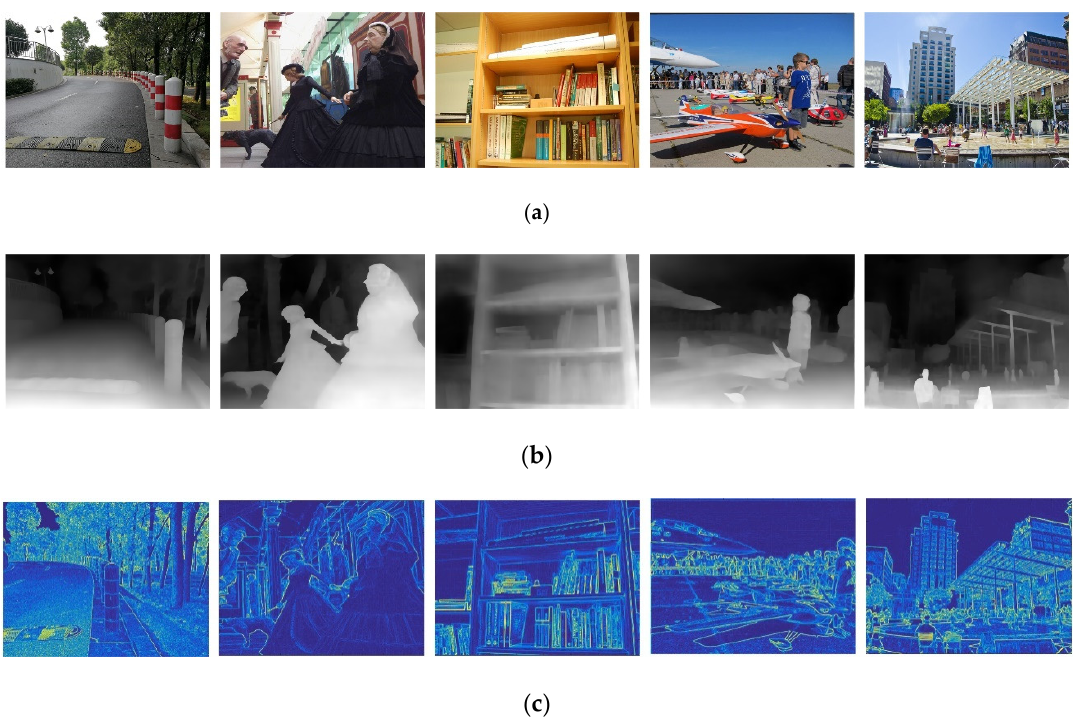
Figure 3. Depth maps and texture maps of different scenes. ( a ) Testing scenes. ( b ) Depth maps obtained with the method in [25]. ( c ) Texture maps obtained with the method in [26] where heat maps are used for clear display.